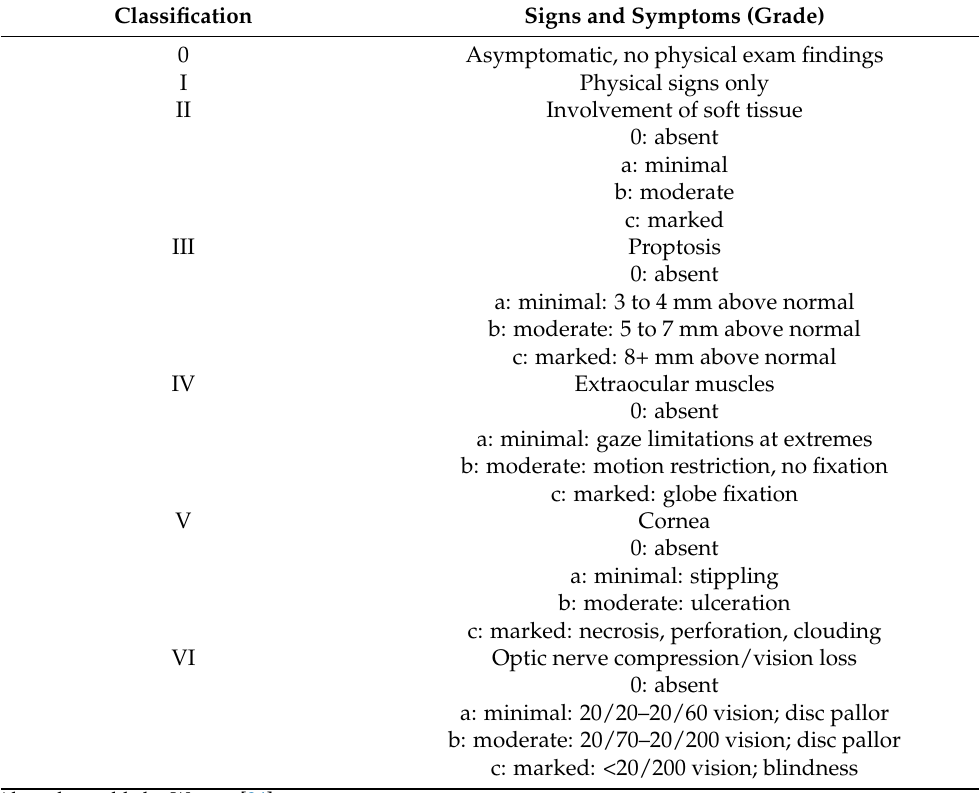
Table 2. NO SPECS classification of Graves’ Eye Disease *. Classification Signs and Symptoms (Grade) 0 Asymptomatic, no physical exam findings